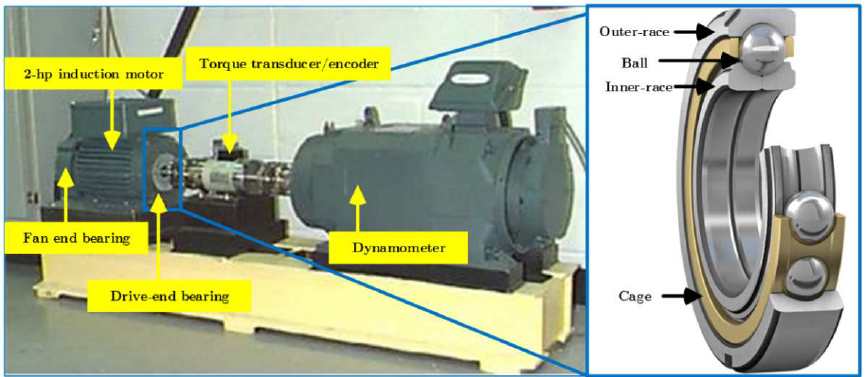
Figure 7. Bearing test rig used for the experiment. Table 1. Detailed information of the CWRU dataset.